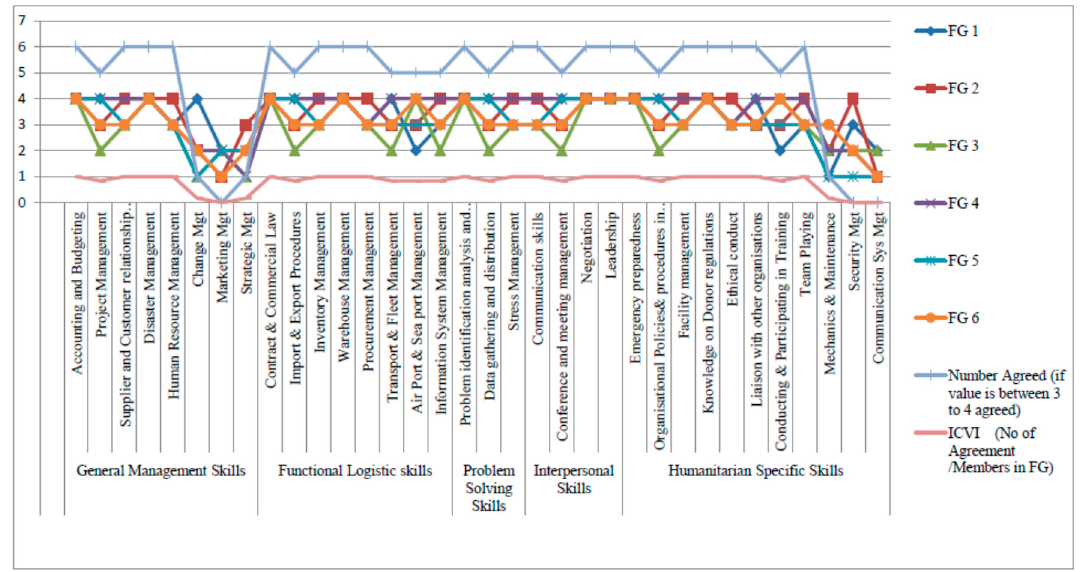
Figure 3. Content validity. (All items that have ICVI values more than 0.78 were considered for the questionnaire. SCVI value was not considered since ICVI values were more than 0.78) Calculations of HL skills (Source: Survey data).